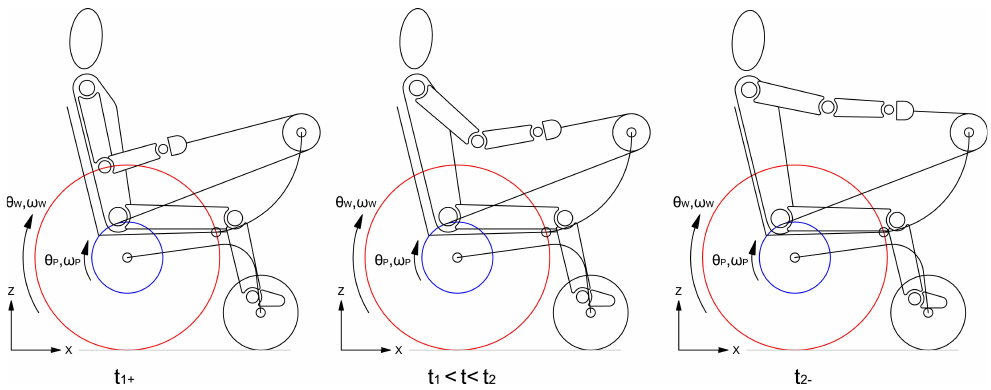
Figure 2. Rowing gesture during the recovery